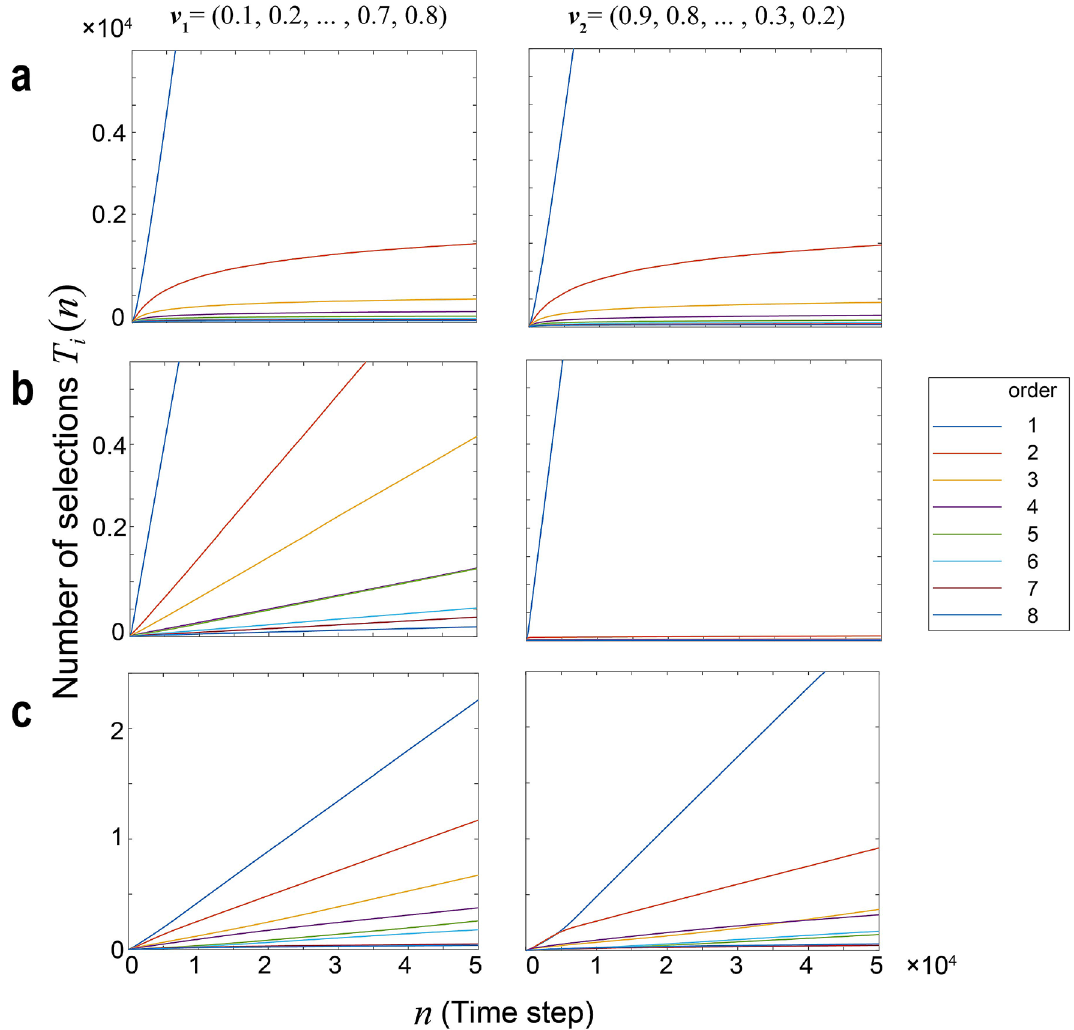
Figure 4. Time evolution of the selection number of each arm for three methods: UCB1, Chaos, and Chaos-CI. The three figures on the left represent T i ( n ) under reward environment ν 1 , and the three on the right represent under ν 2 . Each row represents the result of each method: ( a ) UCB1, ( b ) Chaos, and ( c )